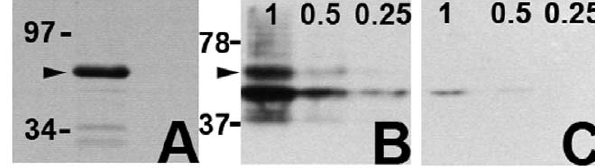
Figure 1. The Cx40.8 antibody is specific. (A) An antibody raised against a Cx40.8 carboxy-terminal peptide detects a single major band from regenerating fin lysates (arrowhead). Non-competed (B) and competed (C) anti-Cx40.8 antibody was used to detect bacterially expressed GST-Cx40.8CT. Decreasing volumes of a concentrated lysate were loaded in each lane on two identical gels. When the antibody was pre-incubated with the Cx40.8 target sequence (i.e. competed), antibody binding was reduced in all lanes compared with non- competed antibody. Arrowhead points to the full length product. Bands at molecular weights smaller than the full-length fusion protein represent degradation products.